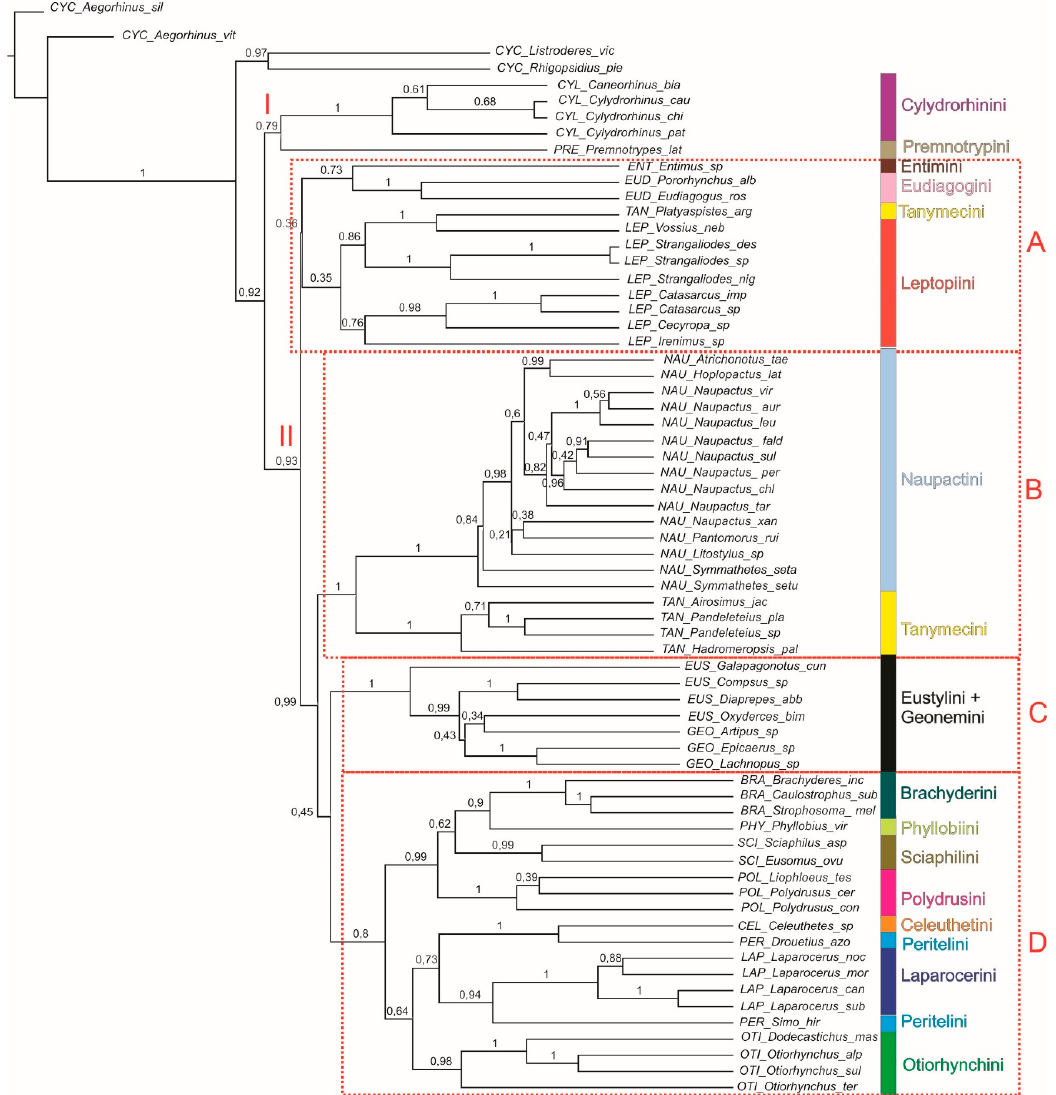
Figure 5. Phylogenetic tree of Entiminae resulting from partitioned Bayesian analysis (MCC) of DNA sequences from four markers and morphological data (see Section 2 Material and Methods). Posterior probability values indicated above branches. Clades discussed in the text are indicated in red (I, II, and A–D).